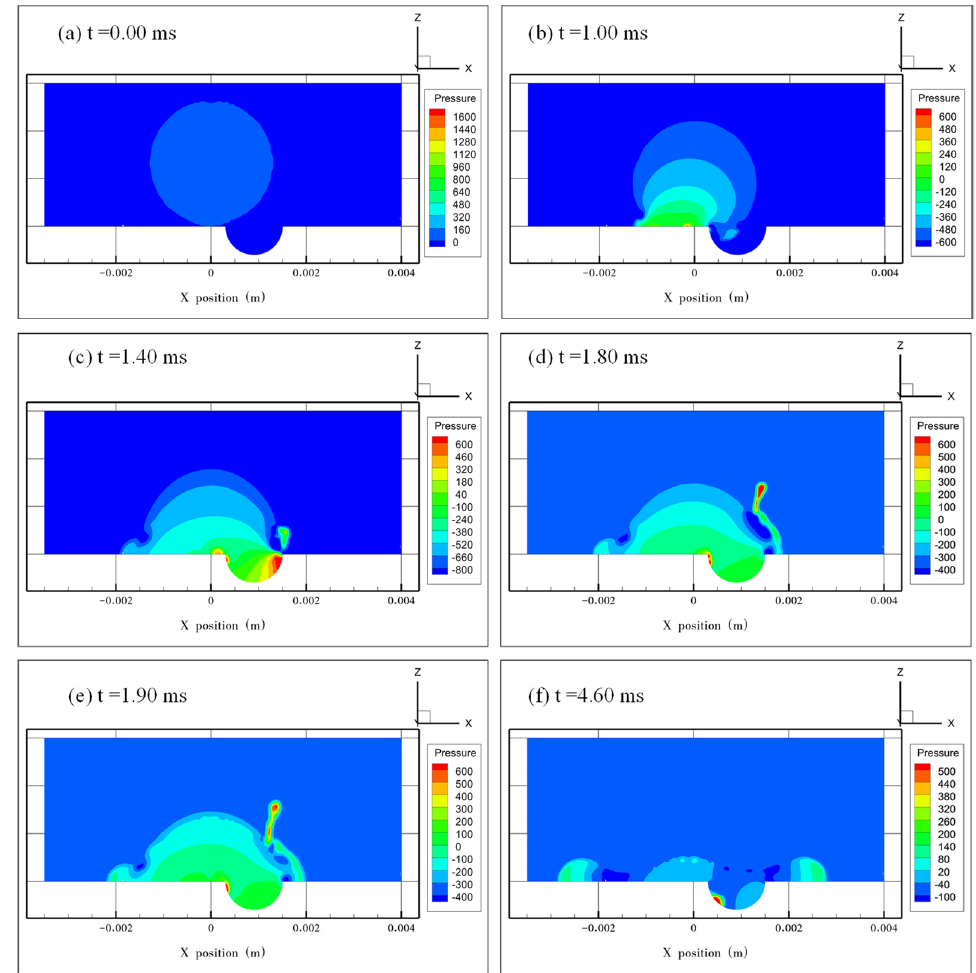
Figure 11. Pressure distribution inside the droplet at e = 0.75. ( a ) The initial pressure distribution when the droplet starts to impact the surface at t = 0.00 ms. ( b ) The maximum pressure occurs on the liquid–solid interface. ( c ) The maximum pressure shifts from the left side to the right side of the dimple with droplet spreading. ( d , e ) The maximum pressure occurs in the tip of the jetting finger during the evolution of the jetting. ( f ) Pressure distribution when the droplet spreads to its maximum diameter.